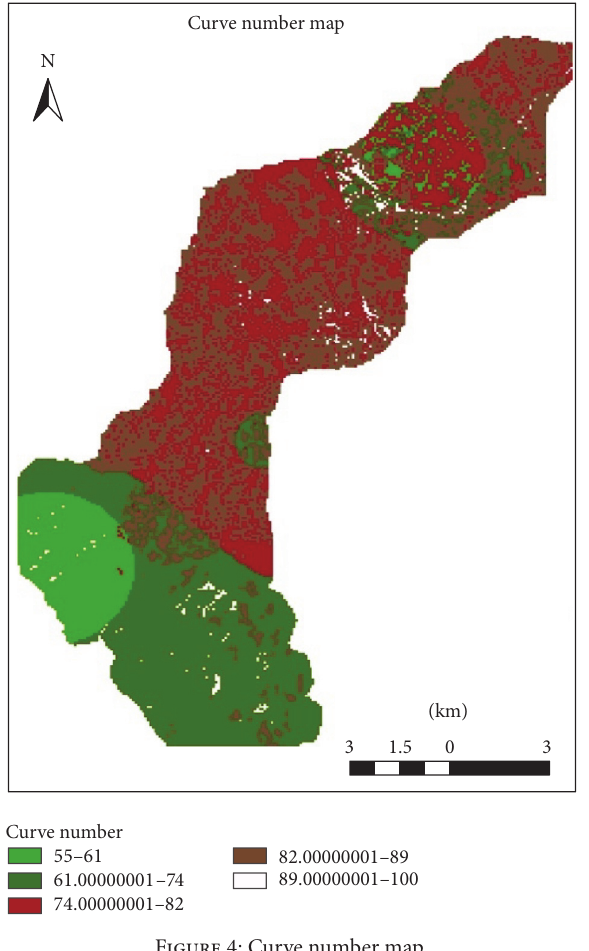
Figure 5: Runoff